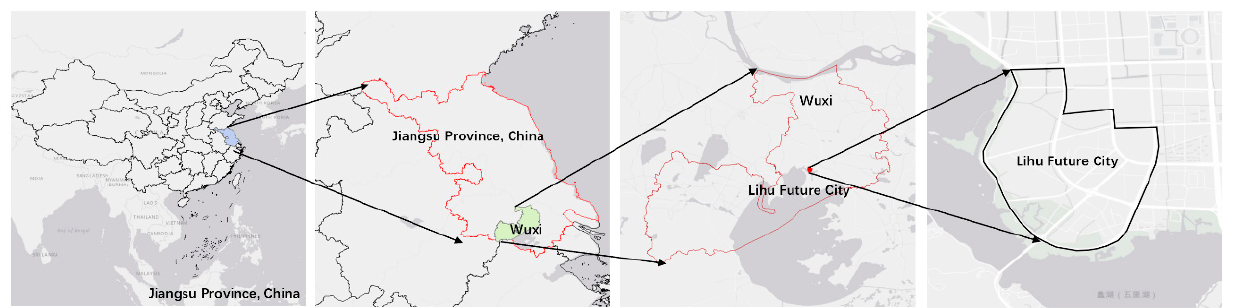
Figure 1. Lihu Future City Location Map.